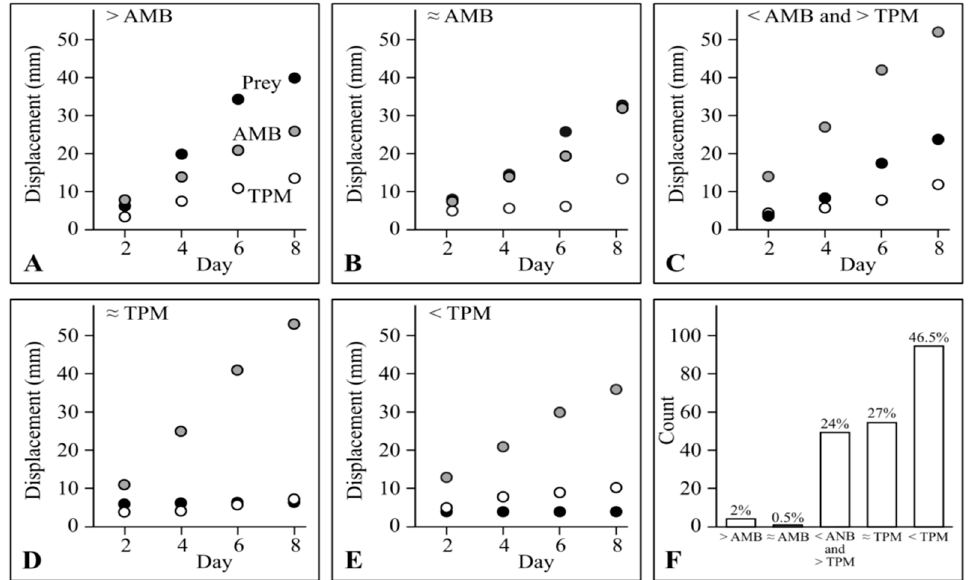
Figure 2. Displacement patterns of myxobacteria. ( A ) CA023 on P. atrosepticum , ( B ) M. xanthus DK1622 on P. atrosepticum , ( C ) M. xanthus AB056 on P. syringae , ( D ) S. cellulosum Soce56 on U. maydis , ( E ) P. fallax DSM 14698 on P. atrosepticum . In ( A – E ), black, grey and white circles indicate displacement on prey, AMB medium and non-nutrient TPM medium, respectively. ( F ) The count (out of 194) and percentage of predator/prey categorization.